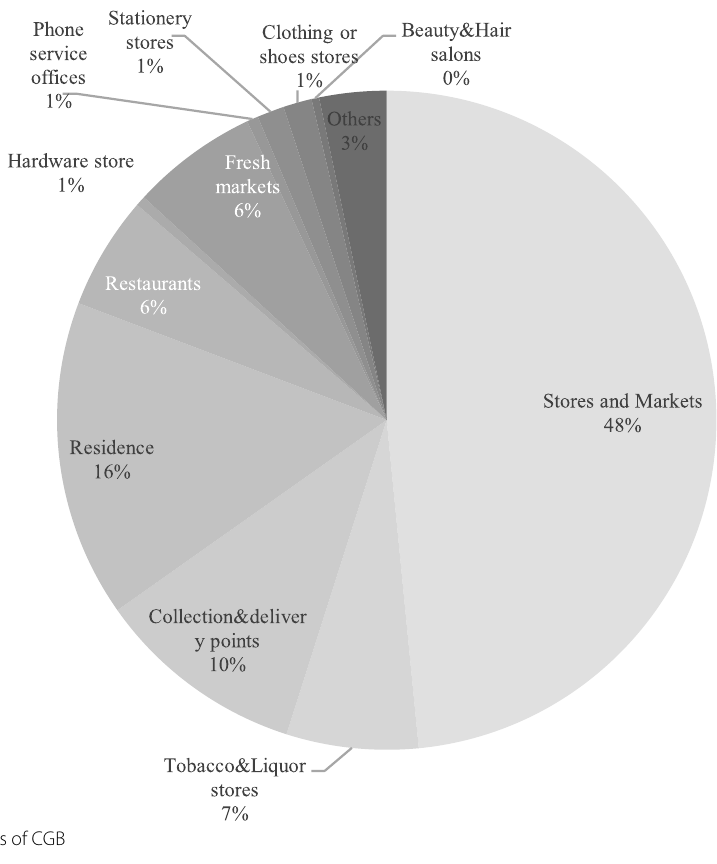
Fig. 3 Relying on the targets of